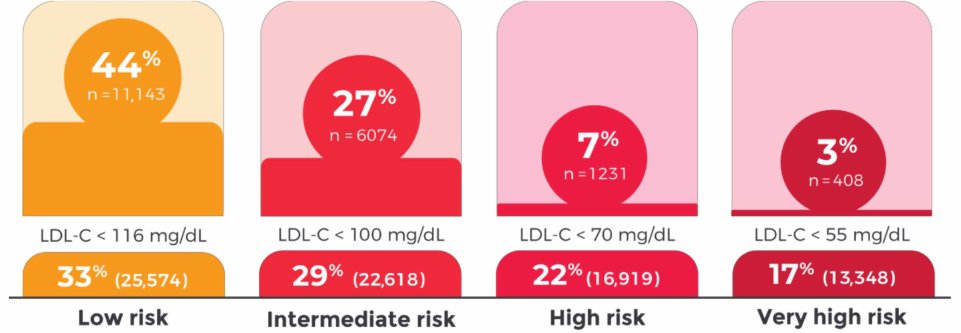
Figure 1. Low-density lipoprotein cholesterol (LDL-C) control by cardiovascular risk category, 2019 ESC/EAS